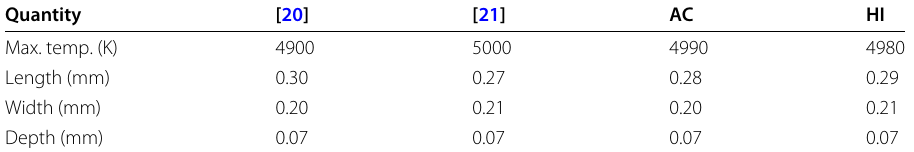
Fig. 16 Surface temperature profile and melt pool shape in steady-state. Current results from HI scheme (top, left) and AC scheme (top, right) as well as reference results from Gusarov et al. [20] (bottom, left) and Hodge et al. [21] (bottom,right) Table 3 Comparison of maximum temperature and melt pool dimensions resulting from the different latent heat